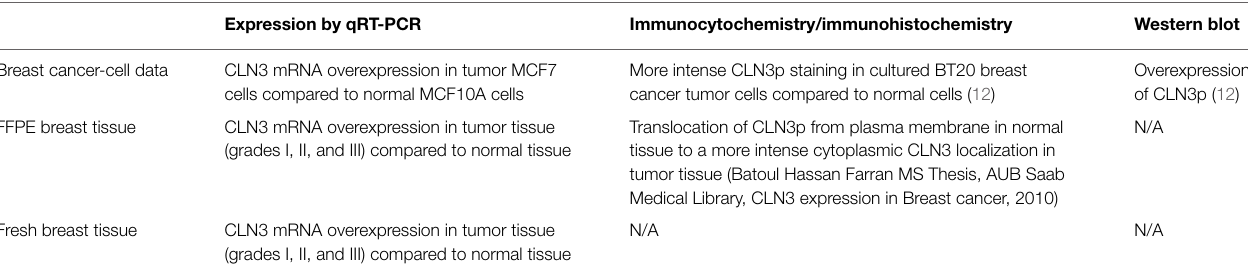
TABLE 2 | Results comparison between cell line, FFPE, and fresh breast tissue studies .